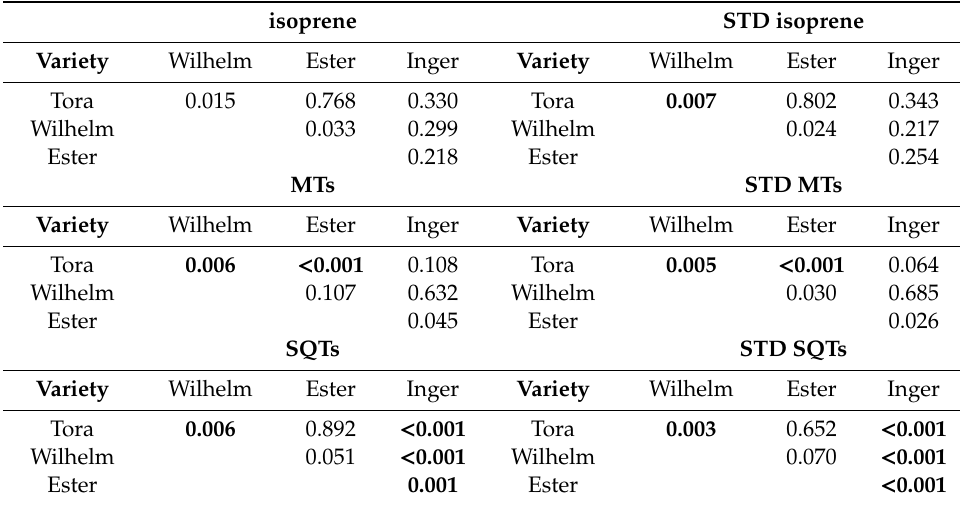
Table 6. The p -values from statistical tests for di ff erences between varieties in measured (upper) and STD (lower) isoprene, total MT and SQT emissions. The p -values originate from pairwise Mann-Whitney U-tests. The significance level after applying a Bonferroni correction is circa 0.008 (0.05 / 6 ≈ 0.008). All p -values written in bold indicate significant di ff